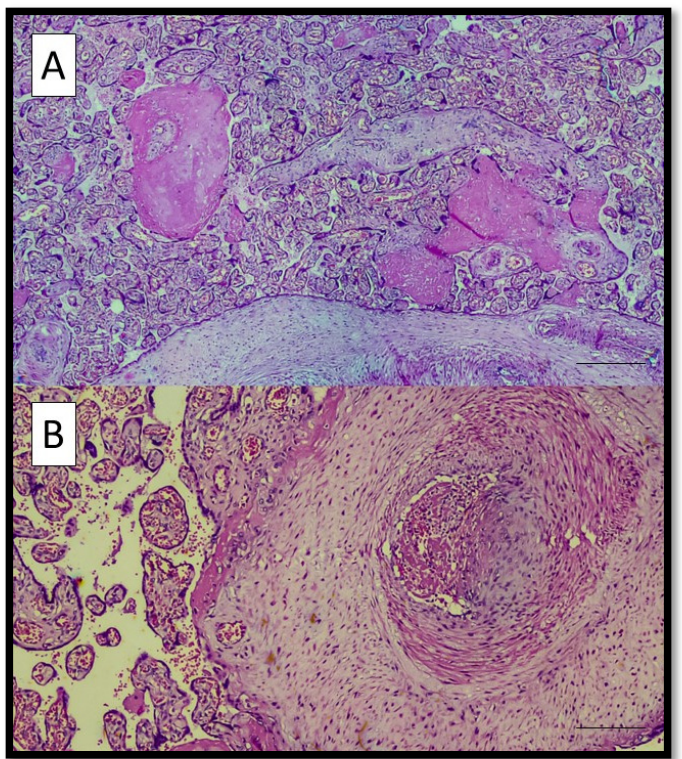
Figure A1. Placental findings in COVID intensive care, COVID not intensive care and control groups ( A ) Histological micrograph shows features of a chorionic disc of a SARS-CoV-2 positive placenta. Note perivillous deposition and morphological characteristics of maternal malpefusion (Hematoxylin-Eosin, Original Magnification 10×). ( B ) Detail of previous image shows a vessel with a thrombus in various stages of organization (Hematoxylin-Eosin, Original Magnification 20×).